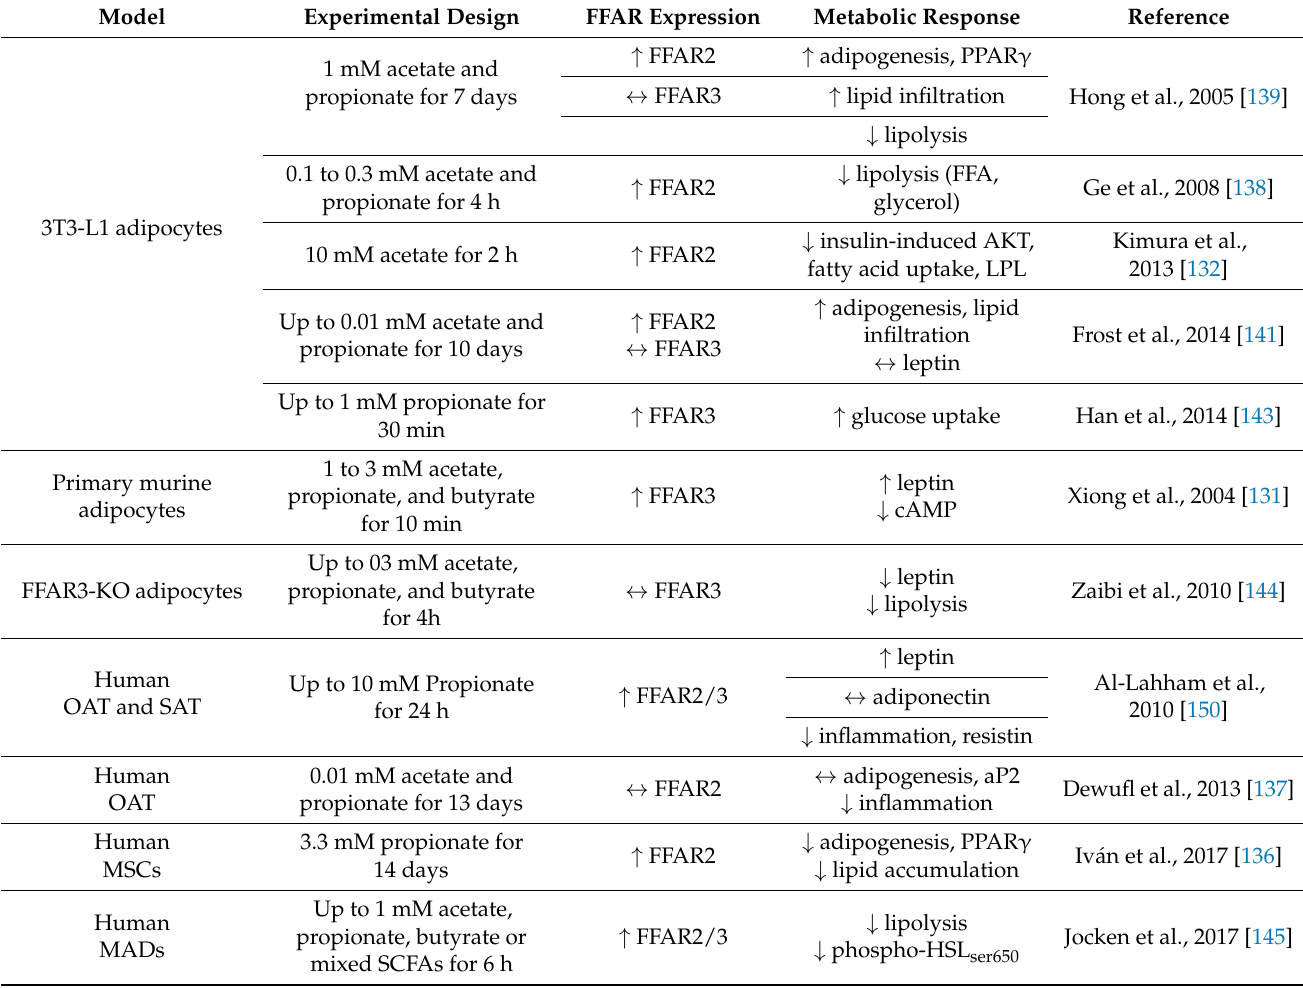
Table 2. Short chain fatty acid receptor signaling in host adipose tissue metabolism in vitro and ex